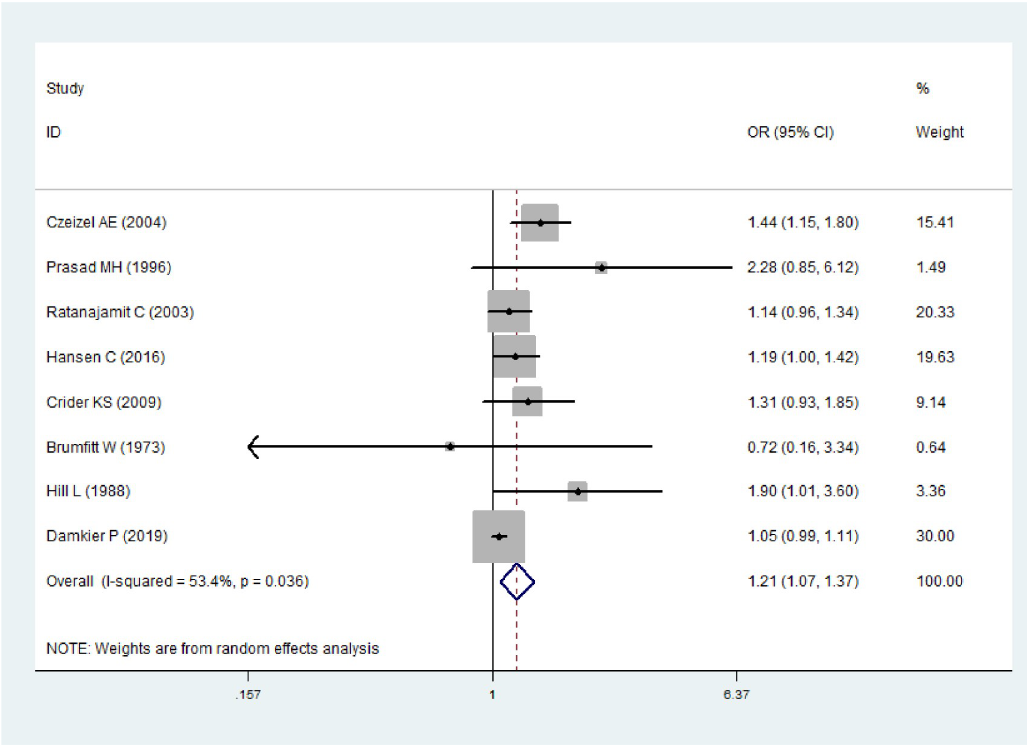
Fig 2. Forest plot with pooled odds ratios of the effect of maternal exposure to sulfonamides on offspring’s congenital malformations.